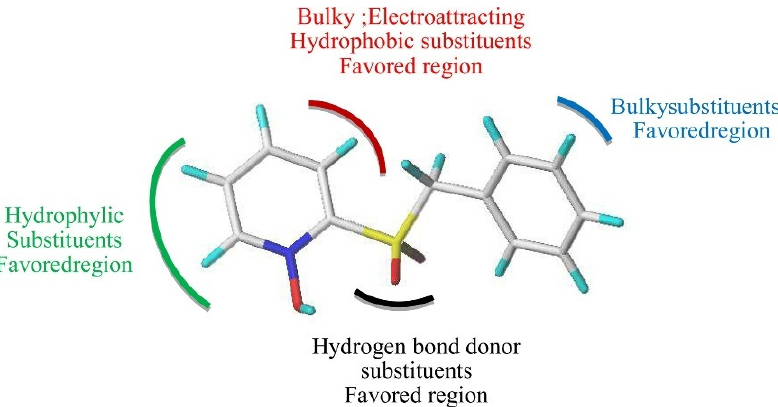
Figure 22. Structures of compounds 222 , 223 , and 224. Continuing their research, the Ghaleb group [100] found the structural conditions that N-oxides must meet in order to have an increased antiviral activity, which is shown in Figure 23. In this study, pyridine N-oxide 223 with SARS-CoV inhibitory activity was selected for a further 3 D-QSAR studies. From 3D QSAR, molecular docking modeling, it was found that compound 224 is more potent than chloroquine and hydroxychloroquine against SARS-CoV-2. Moreover, 223 shows an excellent stability to inhibit the main protease 3CLpro of CoV-2 and also has excellent bioavailability and no toxicity results. In this study, Surflex-Dock was used for molecular docking using SYBYL-X.2.0 software The crystal structure of COVID-19 main protease was downloaded from Protein Data Bank in Europe (PDB ID: 6LU7).